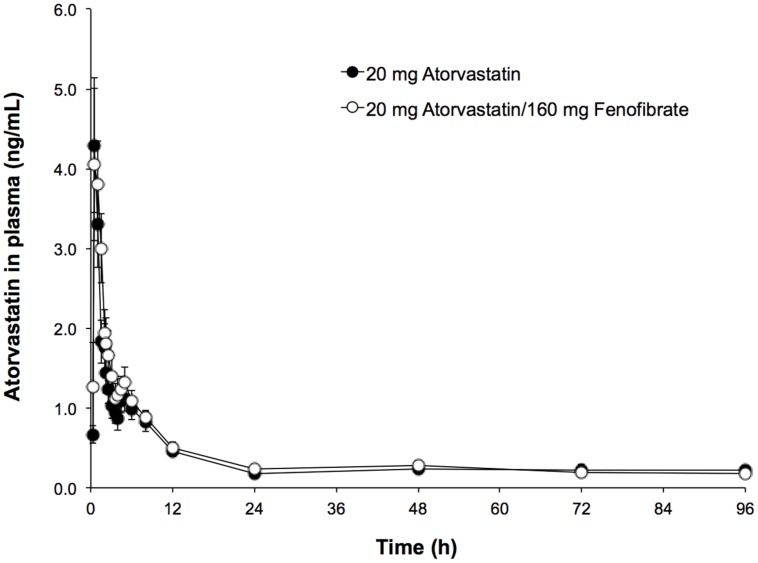
Time-course profile of atorvastatin (ATO) in human plasma of the evaluated formulations.